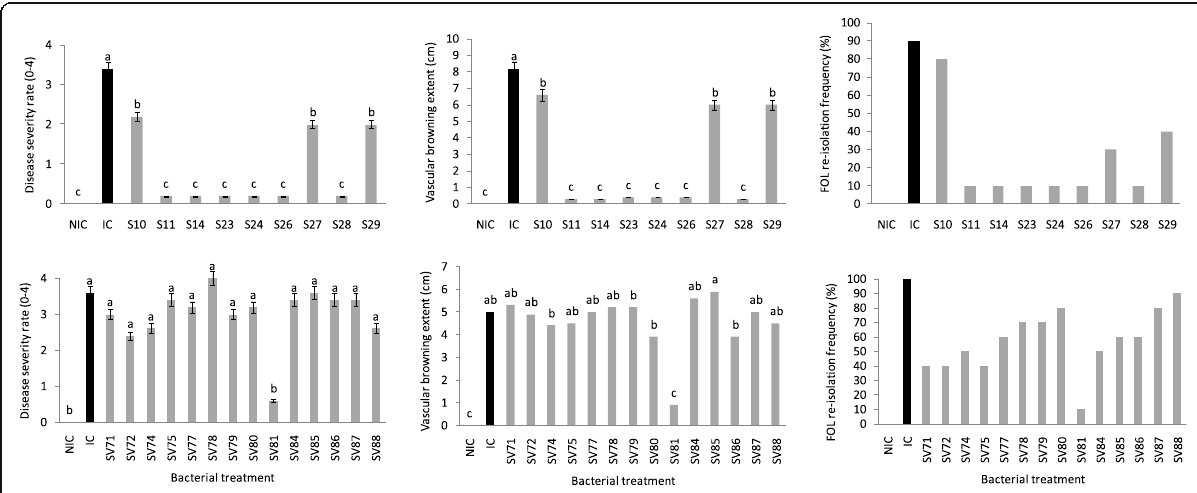
Fig. 3 Effect of various endophytic bacterial isolates, recovered from Solanum sodomaeum and Solanum bonariense , on Fusarium wilt severity noted on tomato cv. Rio Grande plants 60 days post-treatment compared to the untreated controls. S11, S14, S26, S27, S28, and S29 are isolates issued from S . sodomaeum . S23, S24, SV71, SV72, SV74, SV75, SV77, SV78, SV79, SV80, SV81, SV84, SV85, SV86, SV87, and SV88 are isolates issued from S . bonariense . IC, inoculated with Fusarium oxysporum f. sp. lycopersici and untreated; NIC, un-inoculated with pathogen and untreated control. Bars sharing the same letter are not significantly different according to Student-Newman-Keuls test at P ≤